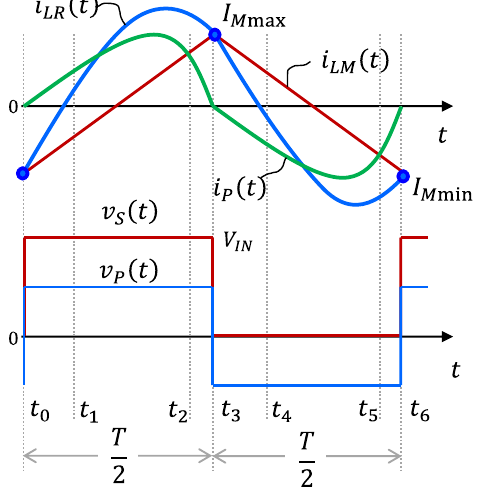
Figure 2. Operating waveform of LLC resonant converter in steady-state.